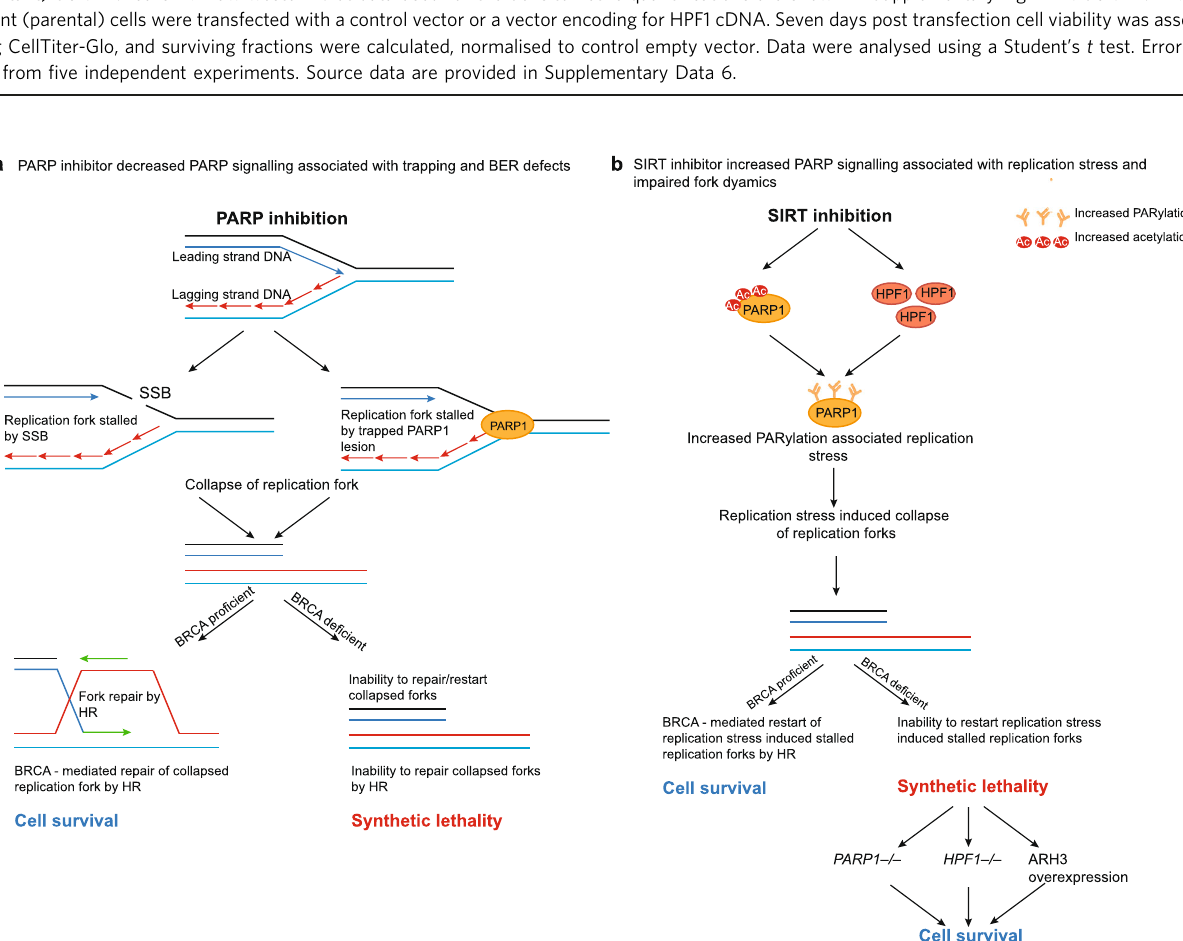
Fig. 6 SIRT6 binds to HPF1 and negatively regulates its protein expression. a HEK293T cells transfected with a control vector or a vector encoding for SIRT1 or SIRT6 cDNA. 48 h later, whole-cell lysates were then immunoprecipitated with anti-FLAG antibody. Subsequently, immunoprecipitates were analysed using western blotting with anti-PARP1, anti-HPF1, anti-FLAG, and anti-H3 antibodies. b SUM149 cells were immunoprecipitated with anti-HPF1, antibody following a 48 h incubation with 50 or 100 µ M EX527. Subsequently, immunoprecipitates were analysed using western blotting with anti-PARP1 and anti-SIRT6 antibodies. c Wild-type HAP1 cells, alongside SIRT1 and SIRT6 knockout HAP1 cell lysates were analysed by western blotting using anti-HPF1 and anti-H3 antibodies. Anti-H3 was used as a loading control. d Densitometric quanti fi cation of HPF1 from wild-type HAP1 cells, alongside SIRT1 and SIRT6 knockout HAP1 cell lysates from fi ve independent experiments, from c , were normalised to H3 or ACTIN loading control, and presented as fold-change over wild-type HAP1 cells. All raw western blot data used for the densitometric quanti fi cations are shown in Supplementary Fig. 14. e HEK293 cells transfected with FLAG-HPF1 or EMPTY control were exposed to 50 µ M EX527 for 48 h incubation. Subsequently, whole cell lysates were analysed by western blotting using anti-FLAG, anti-H3 and anti-PARP1 antibodies. f Densitometric quanti fi cation of FLAG-HPF1, from e . from three independent experiments, normalised